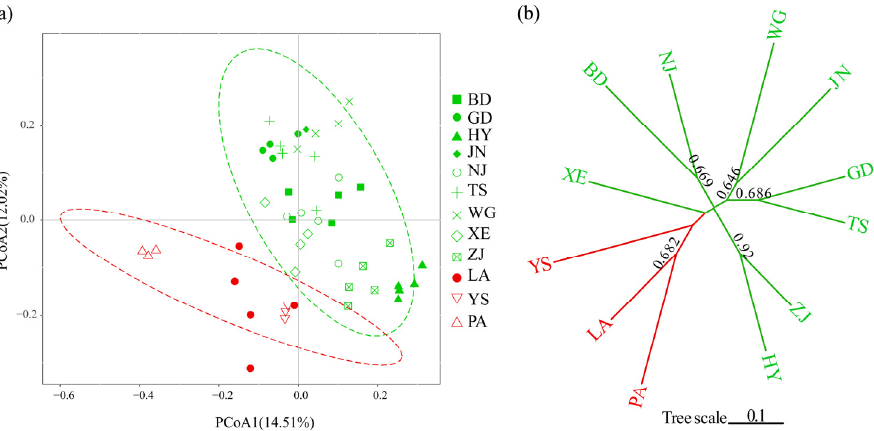
Figure 7. Graphical representation of differentiation between populations. ( a ) Principal coordinate analysis (PCoA). ( b ) Neighbor-joining phylogenetic tree of 60 C. macrophyllum